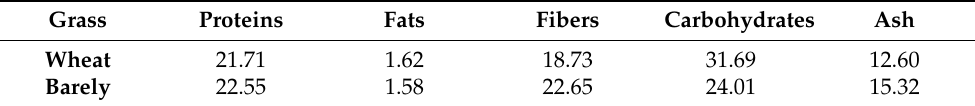
Table 3. Chemical composition (%) of germinated dried wheat and barley.